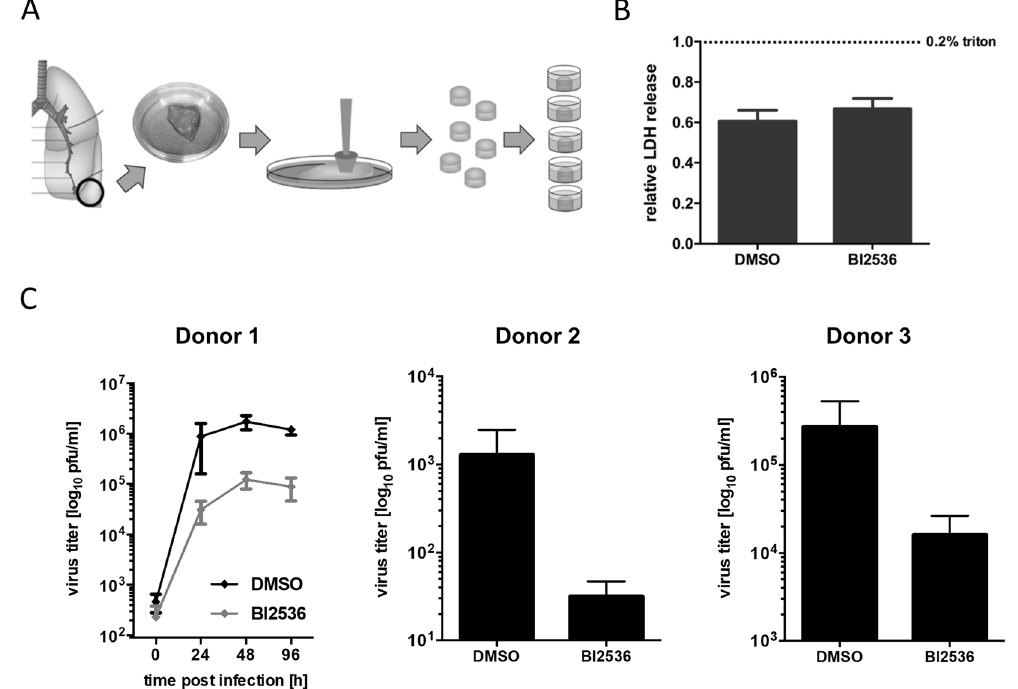
Figure 4. BI2536 inhibits IAV replication in ex vivo human lung tissue. ( A ) Schematic overview of the ex vivo human lung tissue model. Tissue samples were provided by the Cooperative Human Tissue Network which is funded by the National Cancer Institute. Tissue was stamped into small cylinders (diameter of 4 mm), which were incubated individually in primary cell media in 96-well plates. ( B ) PLK inhibition displays no toxicity in the ex vivo human lung tissue model. Tissue samples were treated with 10 uM BI2536, DMSO or 0.2% triton for 48 h. Lactate dehydrogenase (LDH) activity in supernatants was measured and LDH activity at 0.2% triton was set as 1. LDH activity after DMSO or compound treatment was determined relative to the positive control. Four independent experiments with three replicates each were performed and the mean with standard error of the mean is shown. ( C ) PLK inhibition blocks IAV replication in the ex vivo human lung tissue model. Tissue samples were infected with 1 × 10 5 pfu A/Panama/2007/1999 and treated with 10 uM BI2536 or DMSO post infection. Supernatants were collected after 24, 48 and 96 h in case of donor 1 and after 48 h for donors 2 and 3. Viral titers were determined by plaque assay in MDCK cells. Three independent experiments with three or more replicates each were performed and the mean with standard error of the mean is